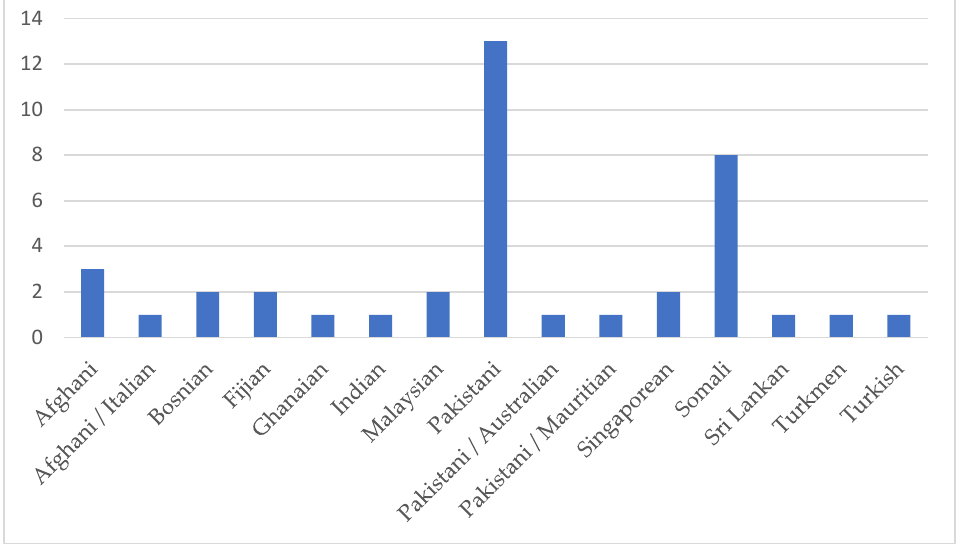
Figure 1. Backgrounds of participants.